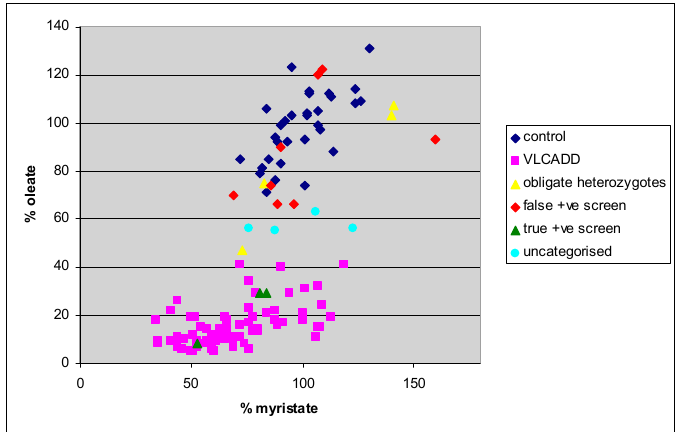
Figure 4. Percentage FAO-flux in VLCADD, obligate heterozygotes, false positive, true positive screened infants and four uncategorized cell lines at 37 °C as compared to normal controls. The FAO-flux results for the cell lines listed in Table 1 following growth and assay at 41 °C are plotted along with the symptomatic VLCADD group (Figure 5). The highest percent oleate FAO-flux